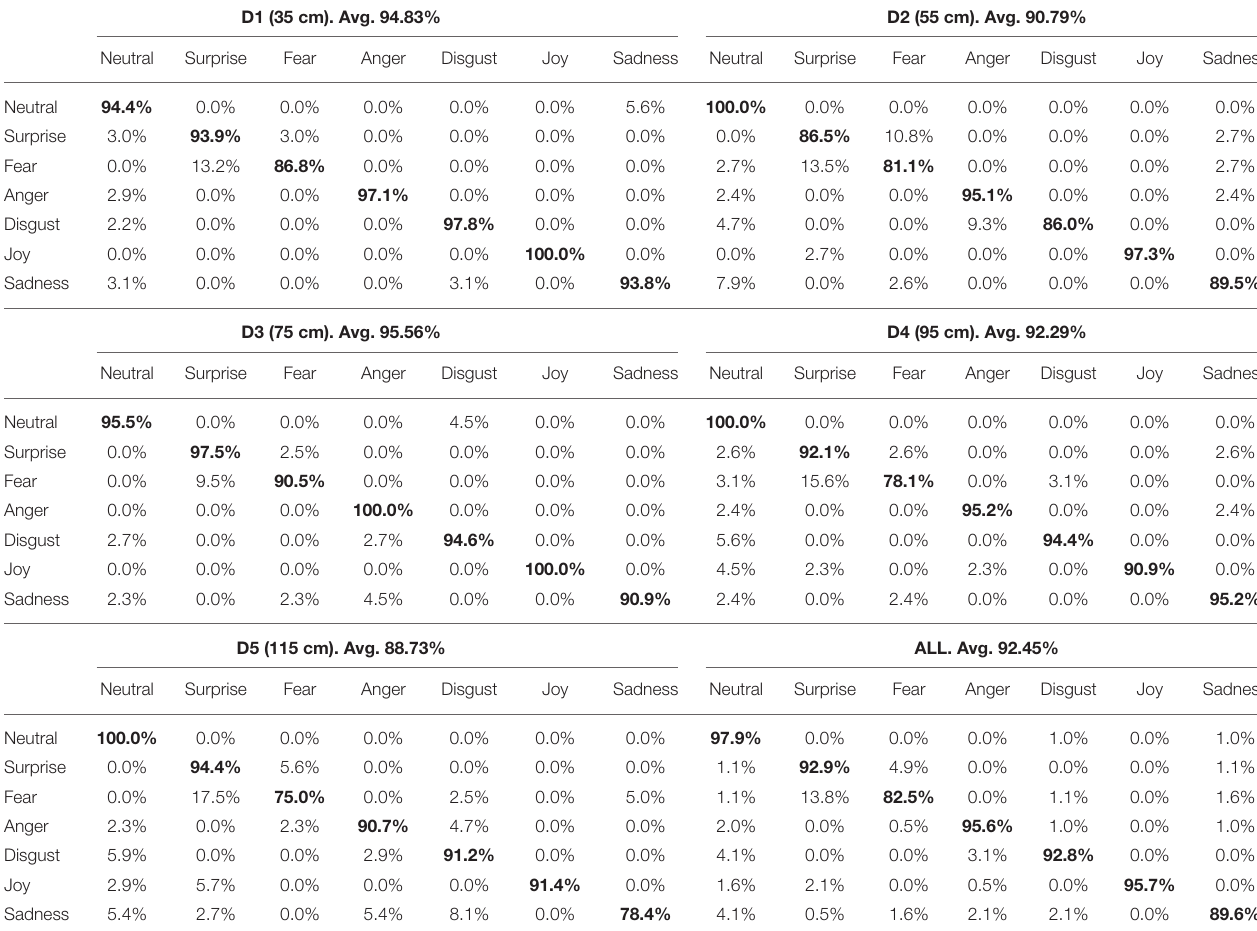
TABLE 4 | Emotion recognition rates and average values of the FRONT view for each interpersonal